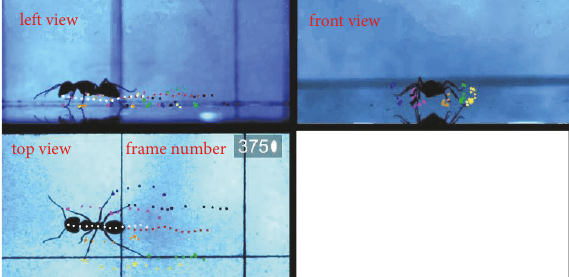
Figure 2: The foot trajectory of locomotion.